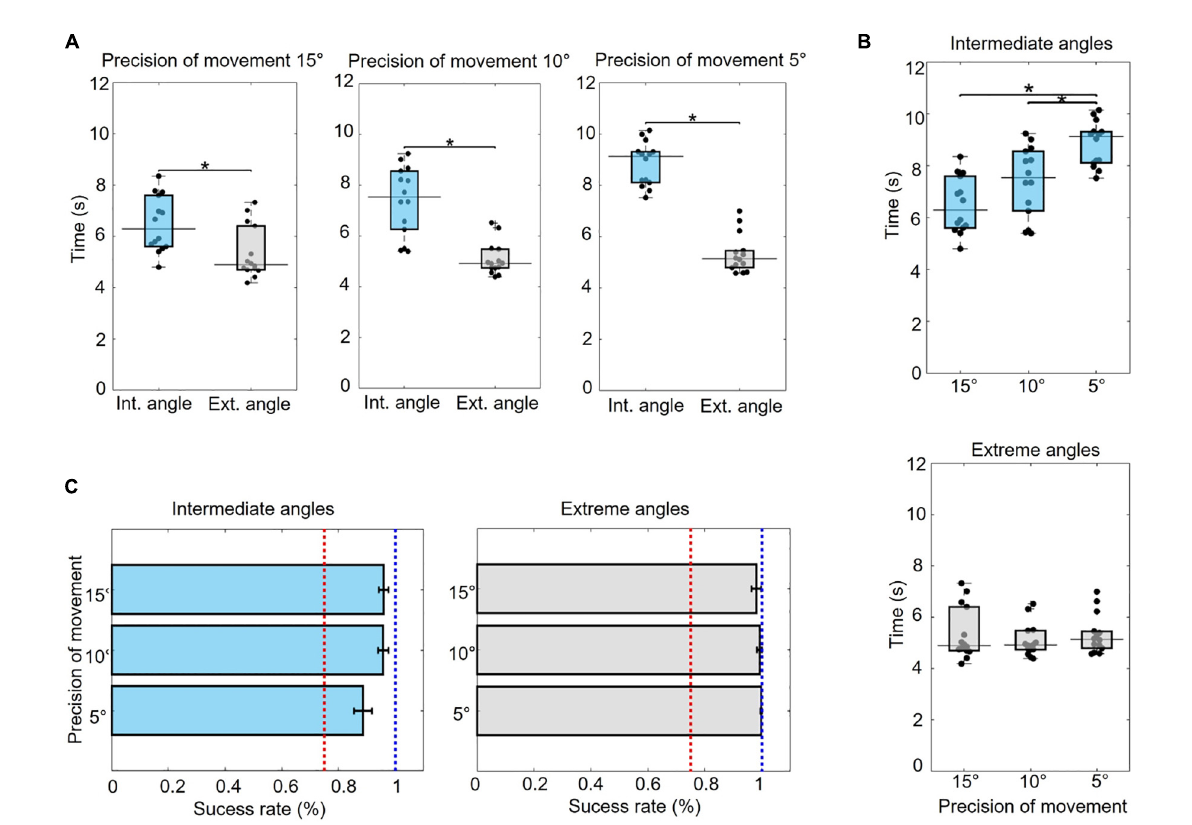
FIGURE5 Motor measurement. (A) Comparison of execution times between the intermediate (30 ◦ and 60 ◦ ) and extreme (0 ◦ and 90 ◦ ) target angles (Mann–Whitney test). (B) Comparison of execution times across levels of difficulty related to the precision of movement (15 ◦ , 10 ◦ , and 5 ◦ of variation in relation to the target angle) for the intermediate and extreme angles (Kruskal–Wallis with Tukey–Kramer correction). (C) Success rate on tasks involving intermediate and extreme target angles at each level of required movement precision (average of the proportion and CI). The red line indicates a success rate of 75%, and the blue line indicates 100%. * p <